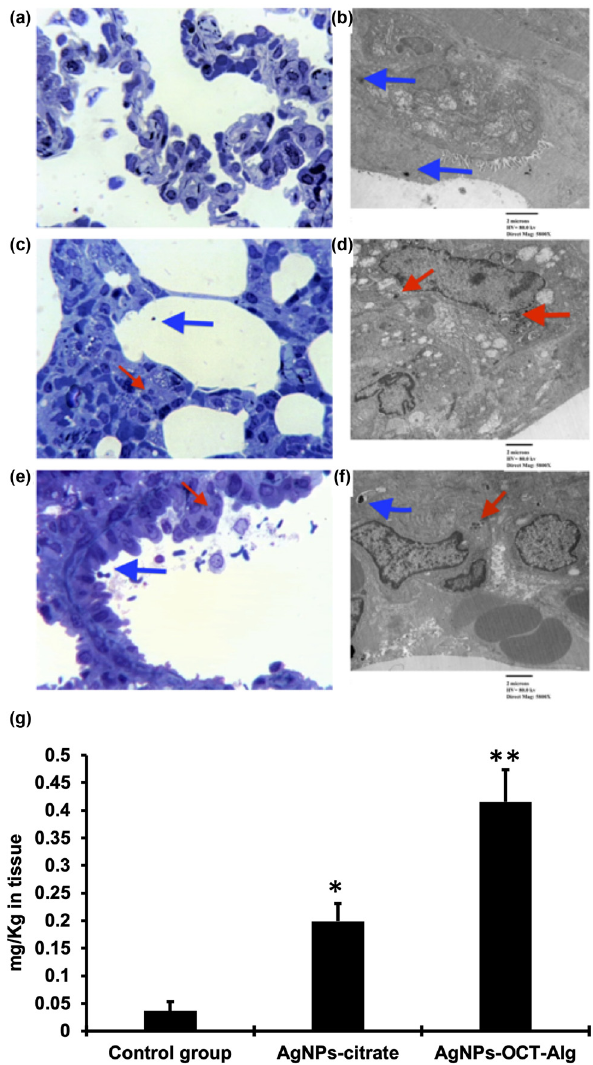
Figure 7: ( a – c ) Photomicrographs of lung sections stained with toluidine blue. Panel b shows inhaled AgNPs – CTT ( red arrow ) and panel c shows inhaled AgNPs – OCT – Alg ( red arrow ) ; ( d – f ) trans - mission electron microscopy ( TEM ) photomicrographs of ultrathin lung sections; the irregularly shaped, comparatively larger black spots are artifacts shown by blue arrows; ( e ) inhaled AgNPs – CTT ( red arrow ) ; ( f ) inhaled AgNPs – OCT – Alg ( red arrow ) ; ( g ) the pro - portions of inhaled AgNPs – CTT, AgNPs – OCT, and AgNPs – OCT – Alg as determined by ICP - OES. The concentrations of AgNPs were 10 µM. * p < 0.05 versus control group, ** p < 0.001 versus AgNPs – CTT group and control